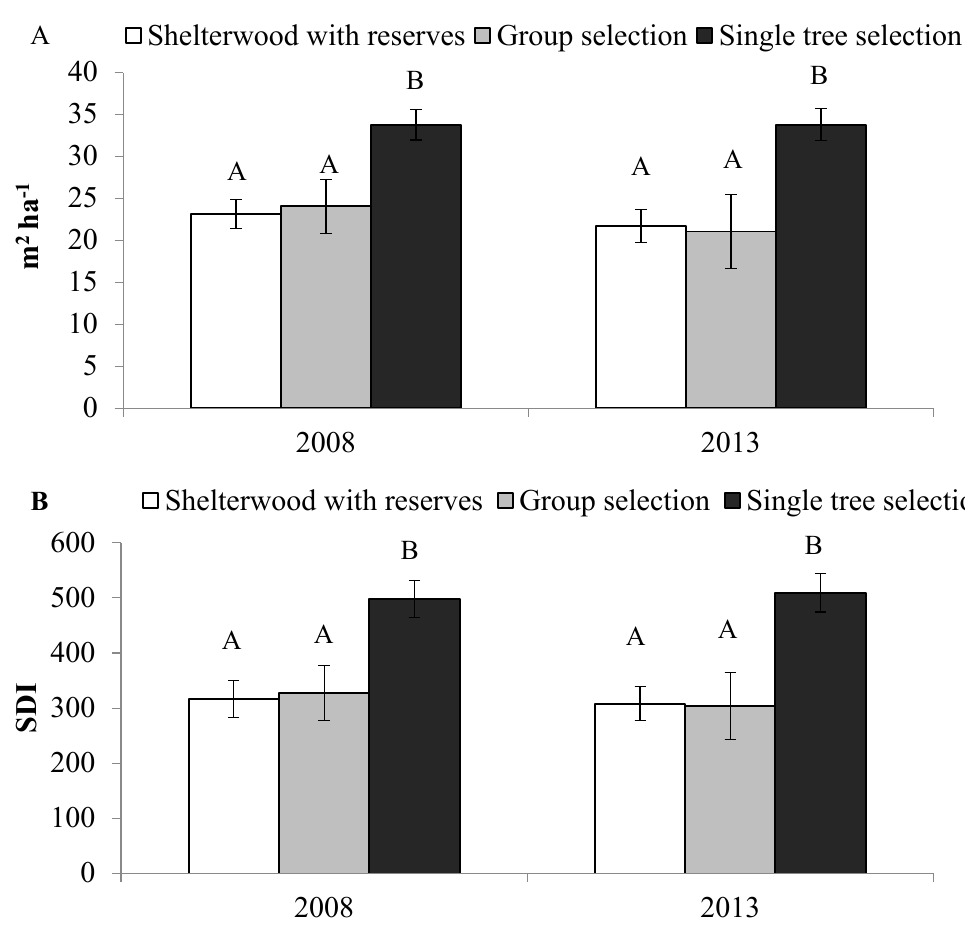
Figure 4. Repeated measures ANOVA for ( A ) live basal area per hectare and ( B ) live stand density index (SDI). The error bars represent the standard errors. Letters represent significant differences between treatments. No significant differences were observed between